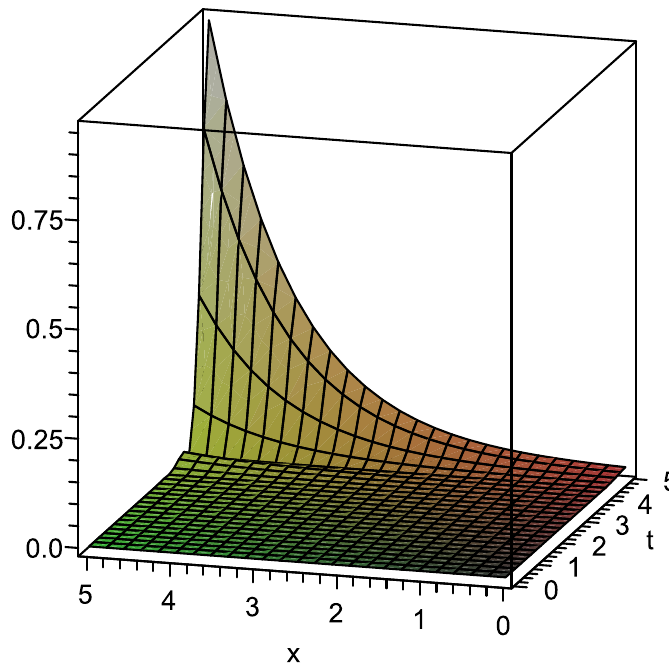
Figure 2. Absolute error for the 16th-order approximation by present method for u ( x , t ) when α = 0.5 and h = 1.52, in Example 1.